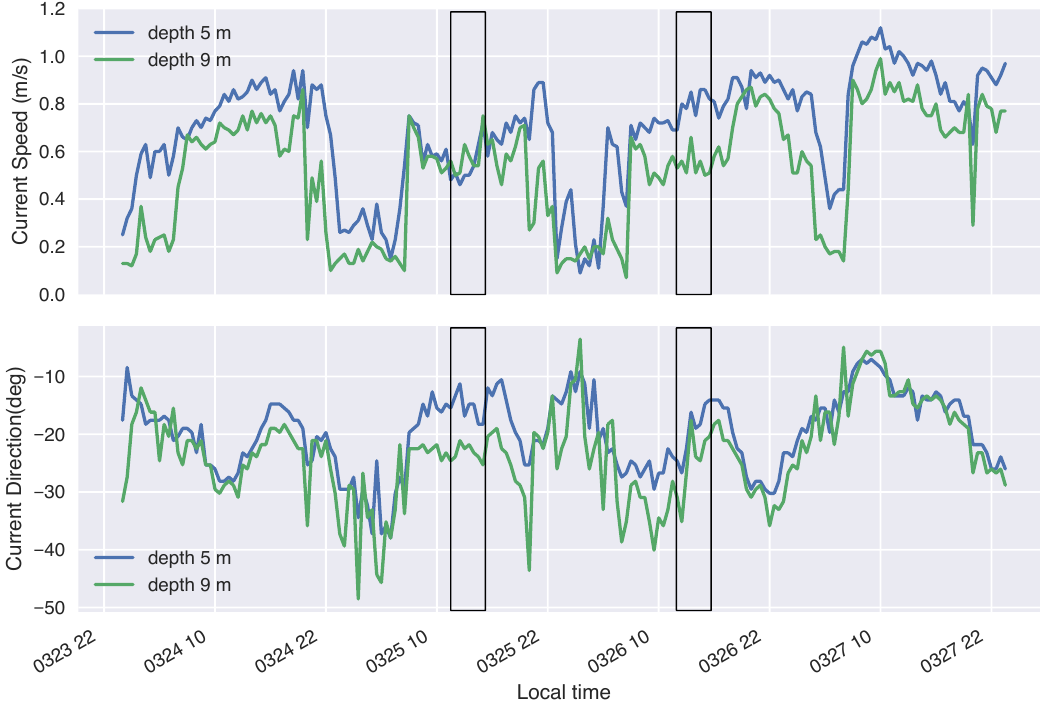
Figure 4. Buoy ADCP measurements for current speed ( top ) and direction ( bottom ) at depths of 5m (blue) and 9m (green). Surface current speed shear was greater on 26 March, but direction differences were smaller. Data collection times are outlined by the black